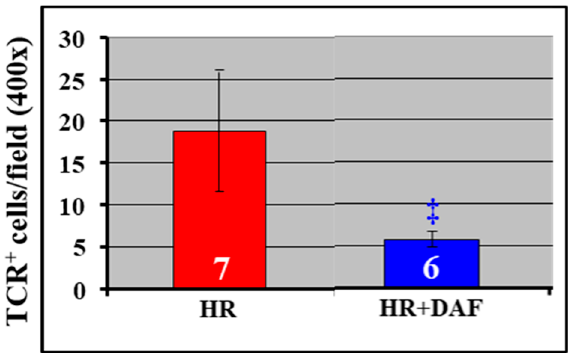
Figure 5. DAF treatment reduces pulmonary infiltration of T lymphocytes in rats with hemorrhagic shock. The number of positively stained cells with anti-TCR antibody and the total number of cells in 20 randomly selected fields at × 400 magnification of a given lung section were determined. The numbers (6, 7) in the figure mark the number of the samples. ‡ p < 0.05 vs. HR (unpaired t ‒ test with Welch’s correction).